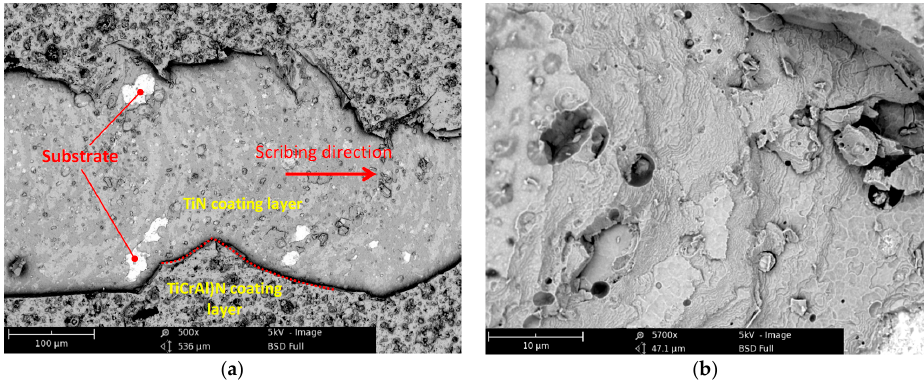
Figure 4. Fracture pattern for multilayered nano-structured coating Ti-TiN-(TiCrAl)N (thickness of about 7 µm) in scratch testing: ( a ) General view of scribing groove in area of L c1 –L c2 ; ( b ) Area of coating fracture.